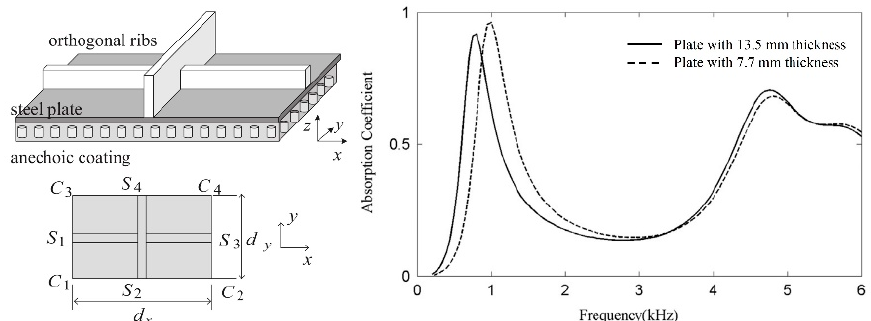
Figure 10. Acoustic radiation of underwater cylindrical shells. Calculating model of a unit cell, its top view, and absorption coefficients of the Alberich anechoic coating backed with different steel plates [47].